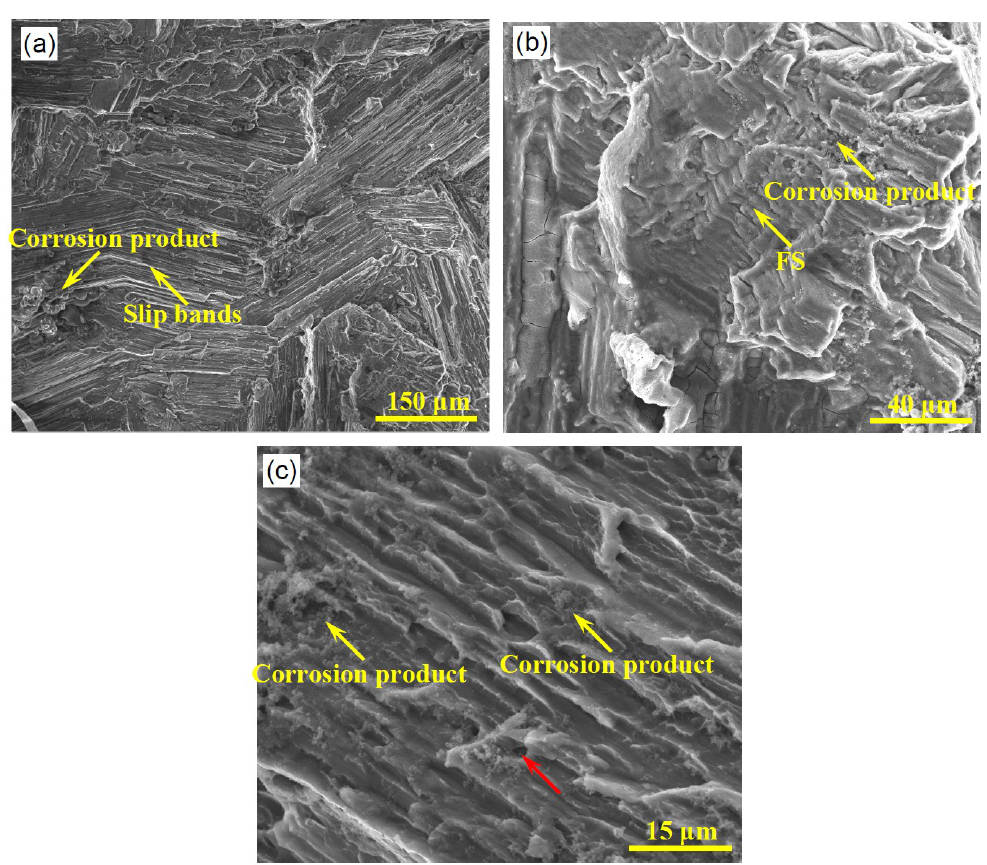
Figure 12. SEM images show the fatigue fracture surfaces of the CS + EP AZ31B Mg alloy specimen tested in the 3.5% NaCl solution at a stress amplitude of 140 MPa to investigate the morphology at different zones: ( a ) slip bands and ( b ) fatigue striation (FS) in the crack propagation zone and ( c ) final fracture zone showing tensile-like fracture morphology.